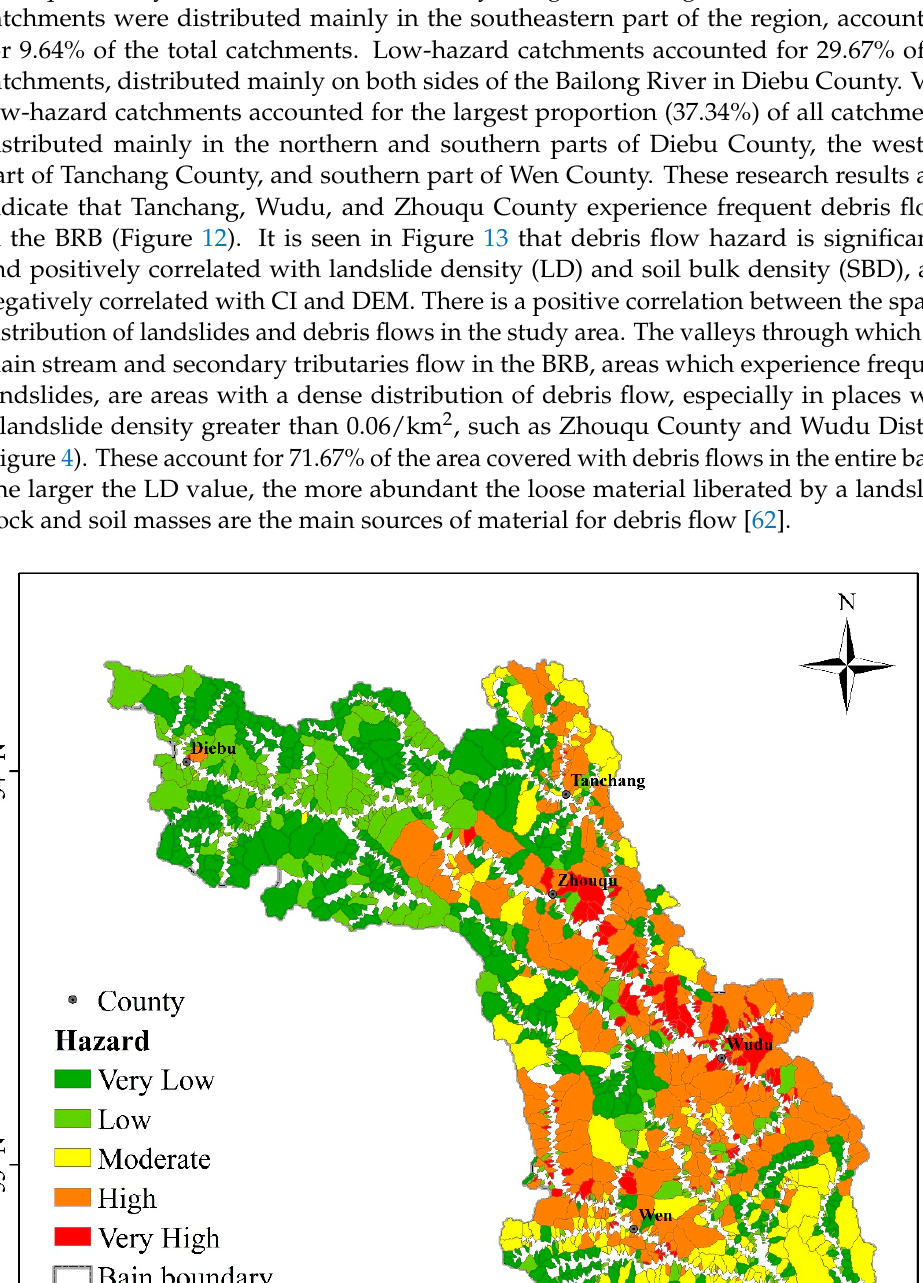
Figure 11. Ten-fold cross-validation ROC curve for the Extra Trees classifier model.